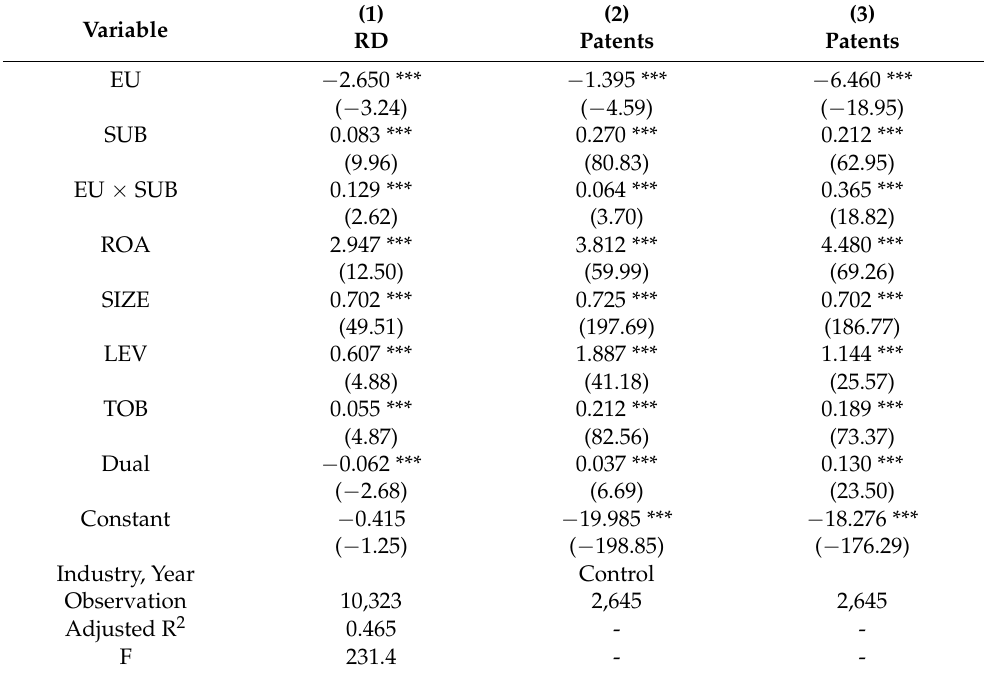
Table 8. The moderating effect of government subsidies on environmental uncertainty and enterprise technological